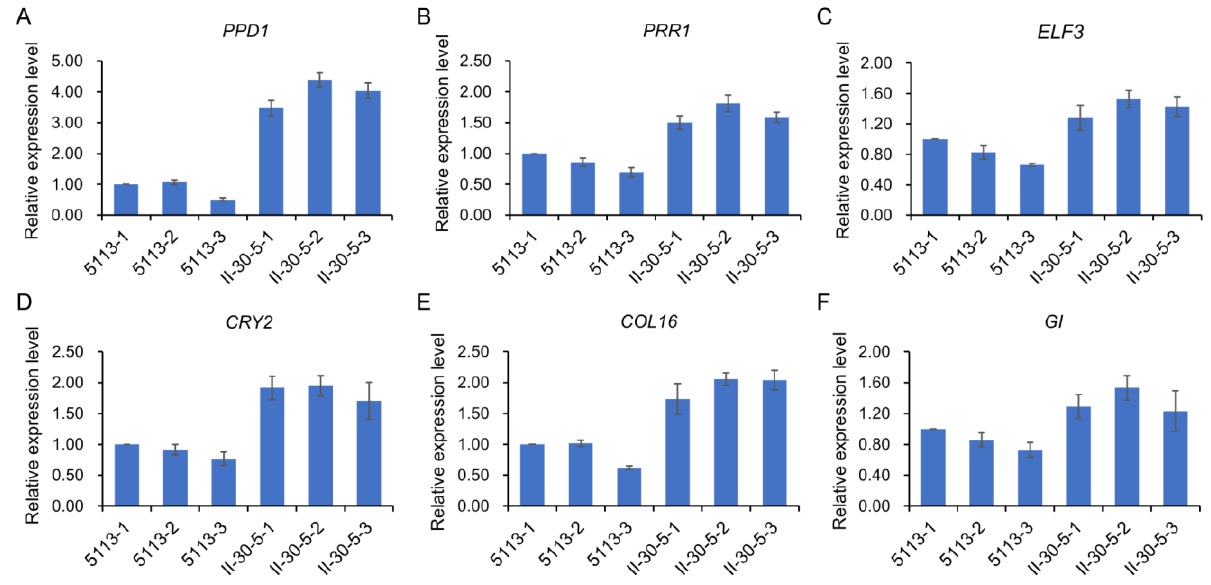
Figure 6. Verification of the expression levels of photoperiod pathway related genes. ( A – F ) Relative expression levels of the photoperiod gene PPD1 ( A ), PRR1 ( B ) ELF3 ( C ) CRY2 ( D ) COL16 ( E ) and GI ( F ) in 5113 and II-30-5 plants. The TaActin was used as a housekeeping gene to calibrate the expression levels of genes.